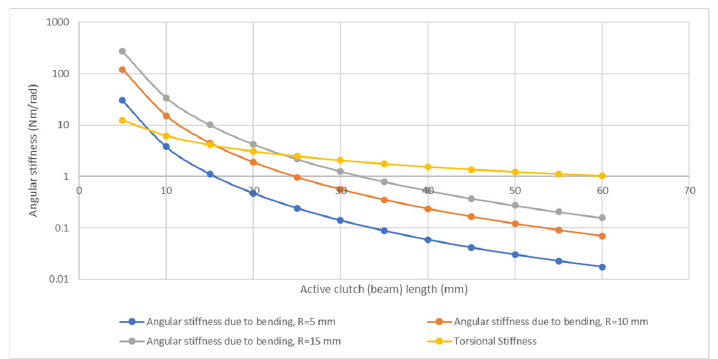
Figure 7. Comparison of the angular stiffness due to bending of the beams with the torsional stiffness of the beams versus active clutch length (analytical results, logarithmic scale).